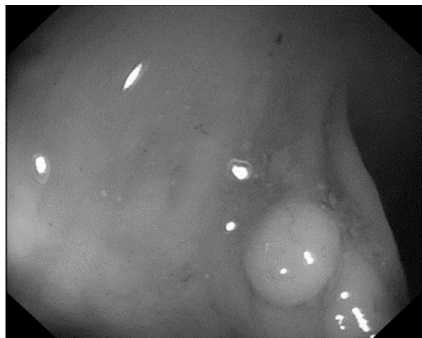
Figure 8. Polyp image after gray scaling.